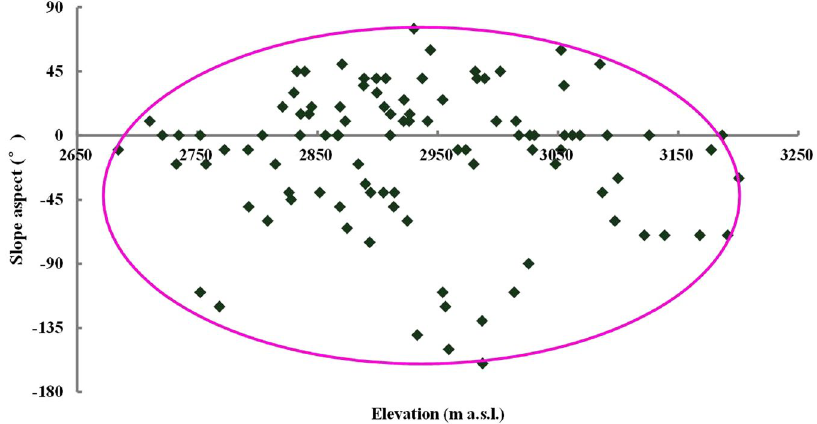
Figure 4. The ellipse shaped potential distribution area of Qinghai spruce forests with relation to elevation and slope aspect in Pailugou watershed. This map was generated using Microsoft Excel 2010 software.